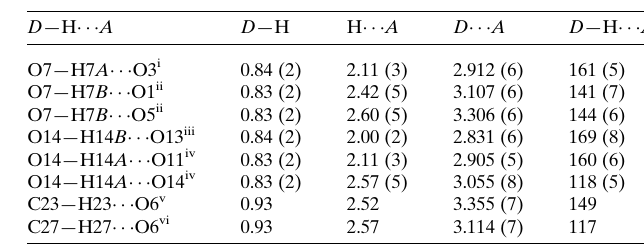
Table 1 Hydrogen-bond geometry (A˚ , (cid:4) ).